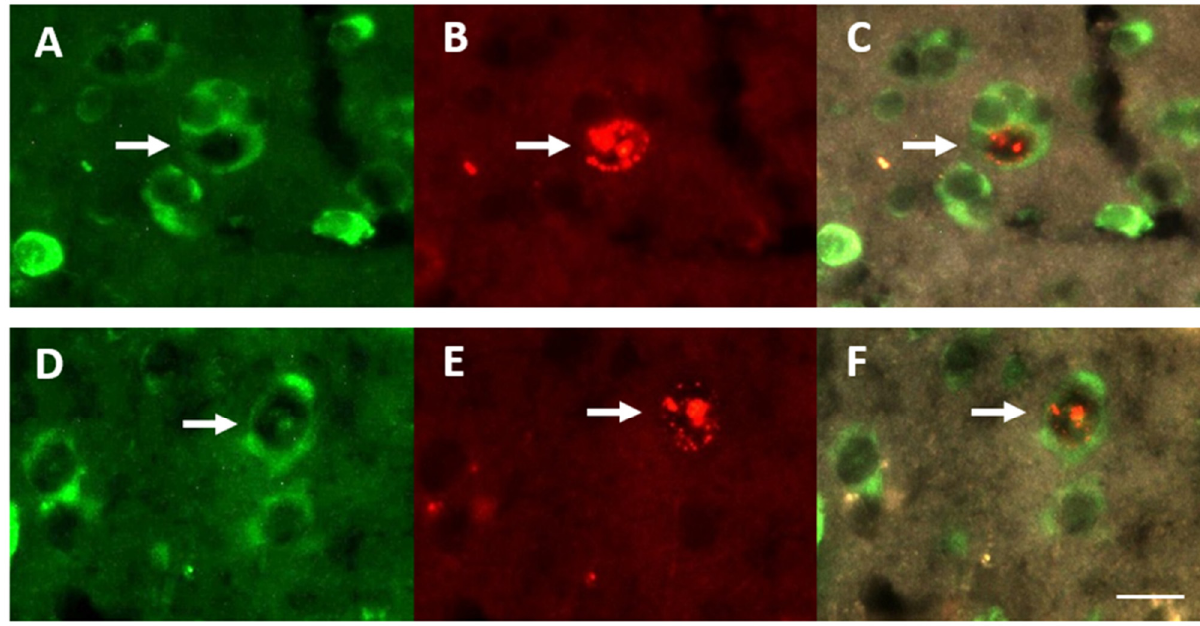
Figure 3. New neurons shown in three microphotographs of the same field, in the Medial Striatum (MSt; upper row ), and the nidopallium caudale (NC; lower row ) in brains of zebra finches ( Taeniopygia guttata ). HU-labelled neurons are shown under a FITC filter ( A , D ), and BrdU-labelled cells are shown under a rhodamine filter ( B , E ). The combined images were obtained using a FITC-rhodamine filter to show co-localization of the two markers ( C , F ). Scale: 10 µm.